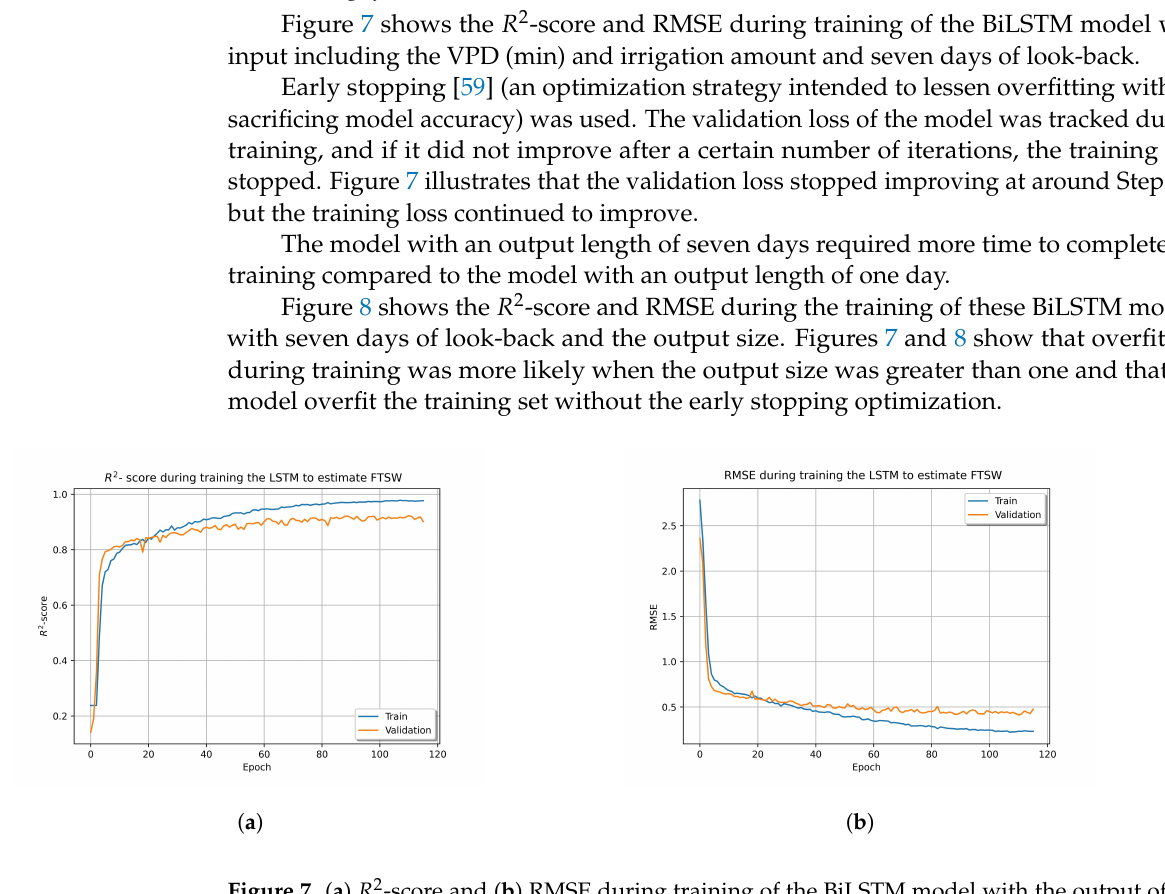
Figure 7. ( a ) R 2 -score and ( b ) RMSE during training of the BiLSTM model with the output of one day, seven days of look-back, and the VPD as the input to the model.